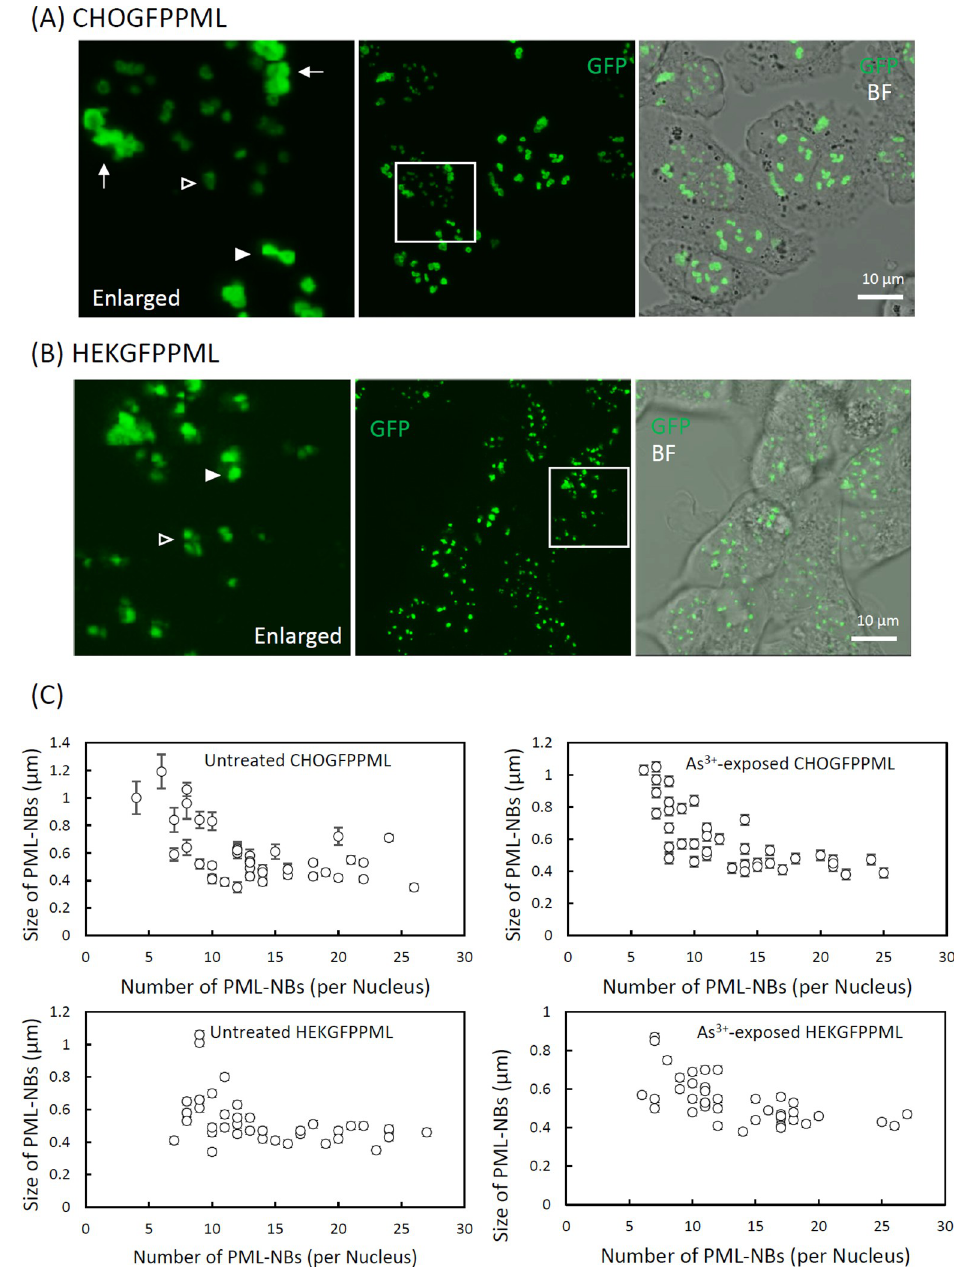
Fig 1. The structure of PML–NBs and peri–nuclear PML aggregates in CHOGFPPML (A) and HEKGFPPML cells (B), and the number and size distribution of PML–NBs (C). GFP live images were obtained by confocal laser scanning microscopy in z–stacking mode. The white boxed area was enlarged to visualize the shapes of PML–NBs and peri– nuclear PML aggregates clearly. (A) PML–NBs occurred as either small toroids (open arrowhead) or large toroids (closed arrowhead) in CHOGFPPML cells. The shape of peri–nuclear PML aggregates (arrow) were also toroidal. (B) PML–NBs occurred either as small (open arrowhead) or large granular dots (closed arrowhead) in HEKGFPPML cells. (C) The cells were pre–cultured in an 8–well chamber slide and treated with 3 μ M As 3+ or left untreated for 2 h. The cells were fixed and counterstained with DAPI. The number and size of PML–NBs in each nucleus were measured by fluorescence microscopy. The size of each PML–NB was estimated as the mean of long and short axes. The measurement was performed on 40 nuclei for each group. Each symbol represents the mean ± SEM of PML–NB sizes in each